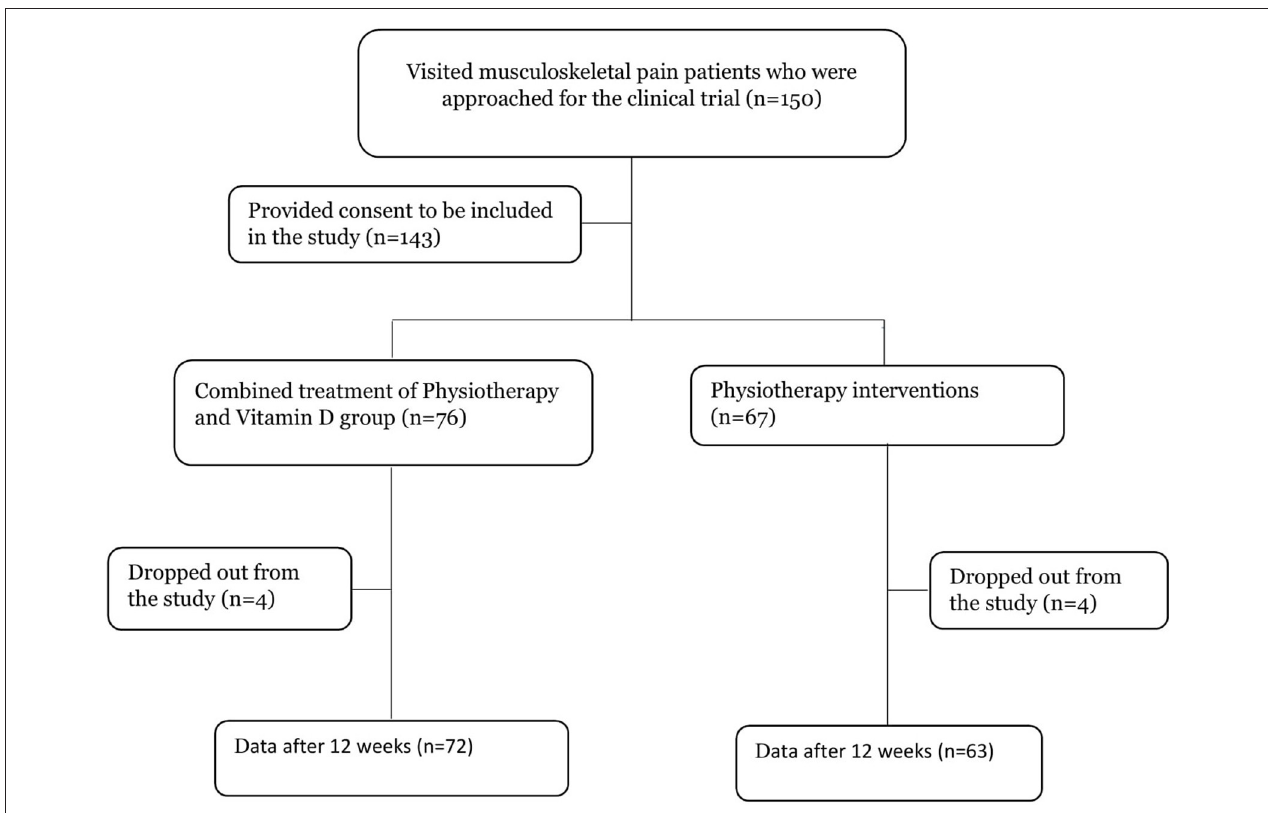
FIGURE 1 | Flow chart of patients’